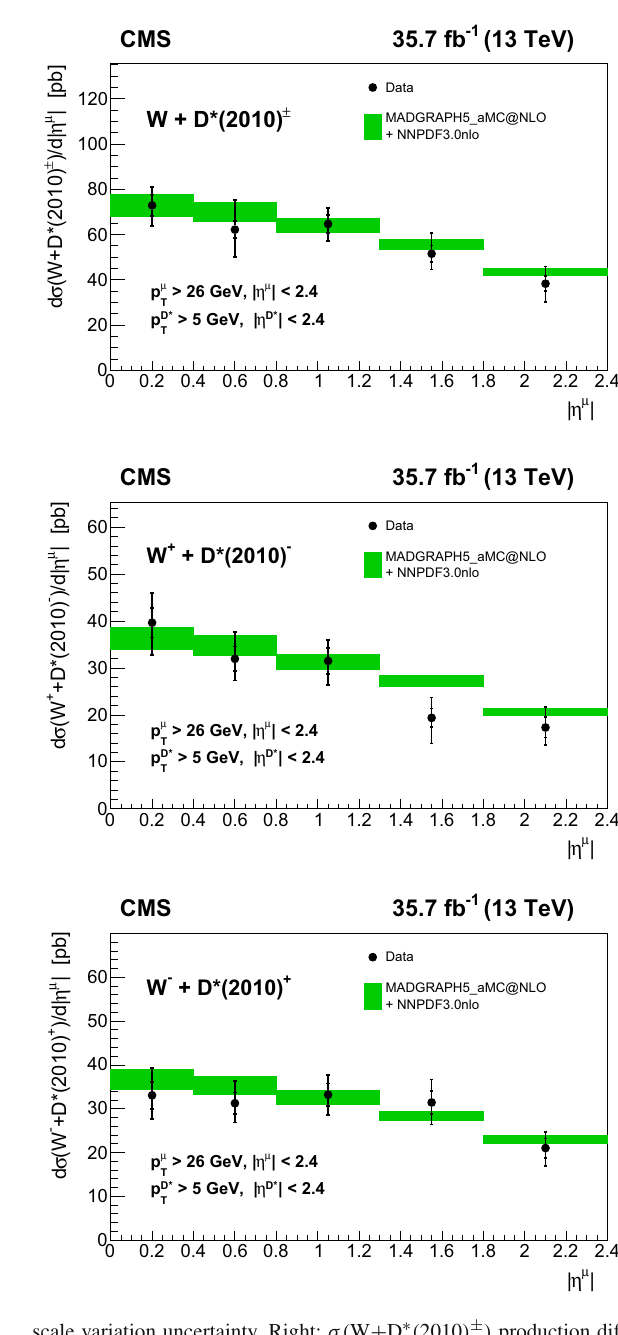
scale variation uncertainty. Right: σ( W + D ∗ ( 2010 ) ± ) production dif- ferential cross sections presented as a function of | η μ | . The data (filled circles) are shown with their total (outer error bars) and statistical (inner errorbars)uncertaintiesandarecomparedtothepredictionsofthesignal MC generated with MadGraph 5_a mc@nlo and using NNPDF3.0nlo to describe the proton structure. PDF uncertainties and scale variations are accounted for and added in quadrature (shaded